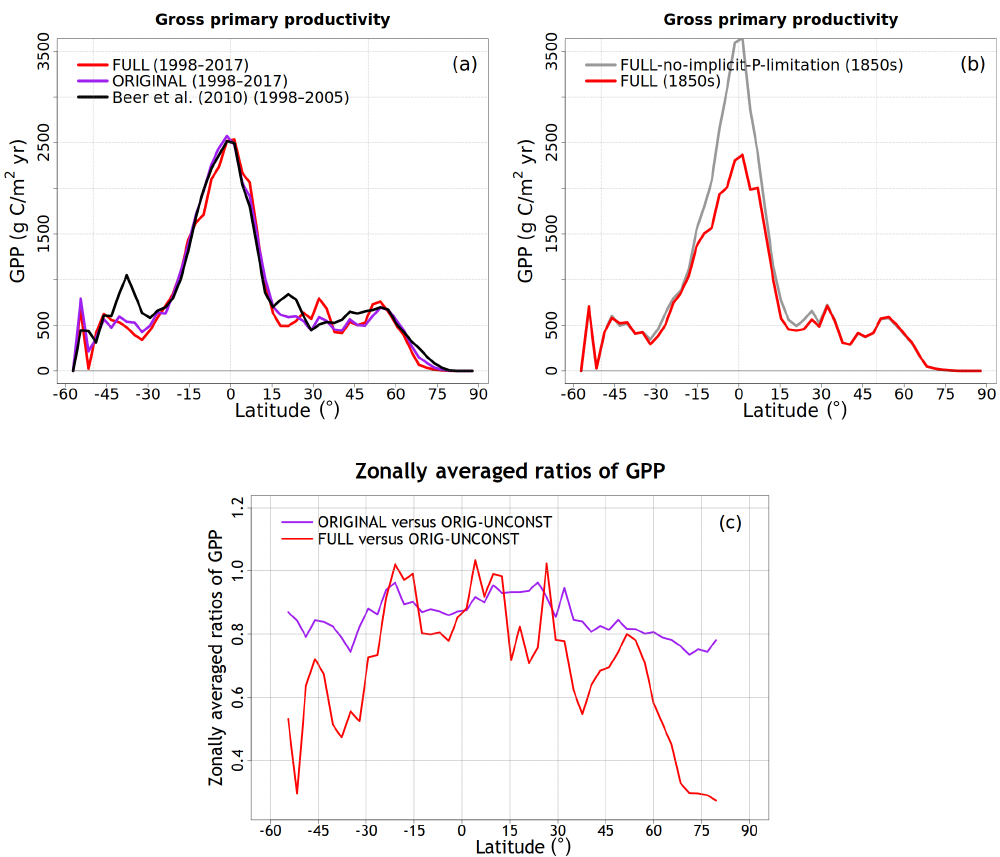
Figure 10. Comparison of zonal distribution of gross primary productivity (GPP) and the effect of GPP downregulation compared to the ORIG-UNCONST simulation. (a) Compares zonal distribution of GPP from FULL and ORIGINAL simulations with observation-based estimate from Beer at al. (2010) for the present day. (b) Compares the zonal distribution of GPP from the pre-industrial simulation, cor- responding to 1850 conditions, from the FULL and FULL-no-implicit-P-limitation simulations to illustrate the effect of not reducing the (cid:48) 1 parameter for calculating V cmax for the broadleaf-evergreen-tree PFT that implicitly accounts for phosphorus limitation. (c) Shows the zonally averaged ratios of GPP from the ORIGINAL and FULL simulations versus those from the ORIG-UNCONST simulations to illustrate how downregulation acts in the ORIGINAL and FULL